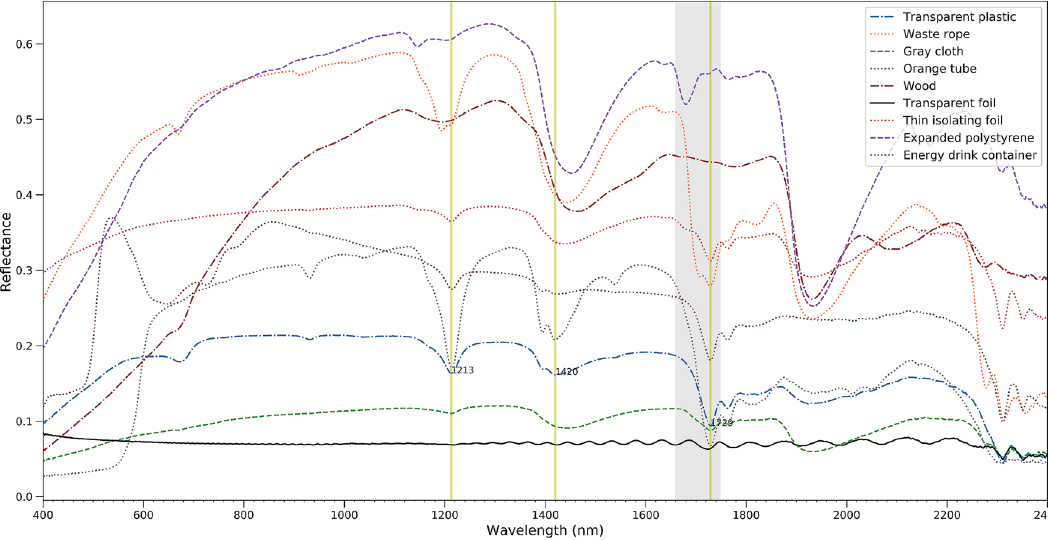
Figure 2. Spectral reflectance of dry natural and anthropogenic materials harvested in the Port of Antwerp in